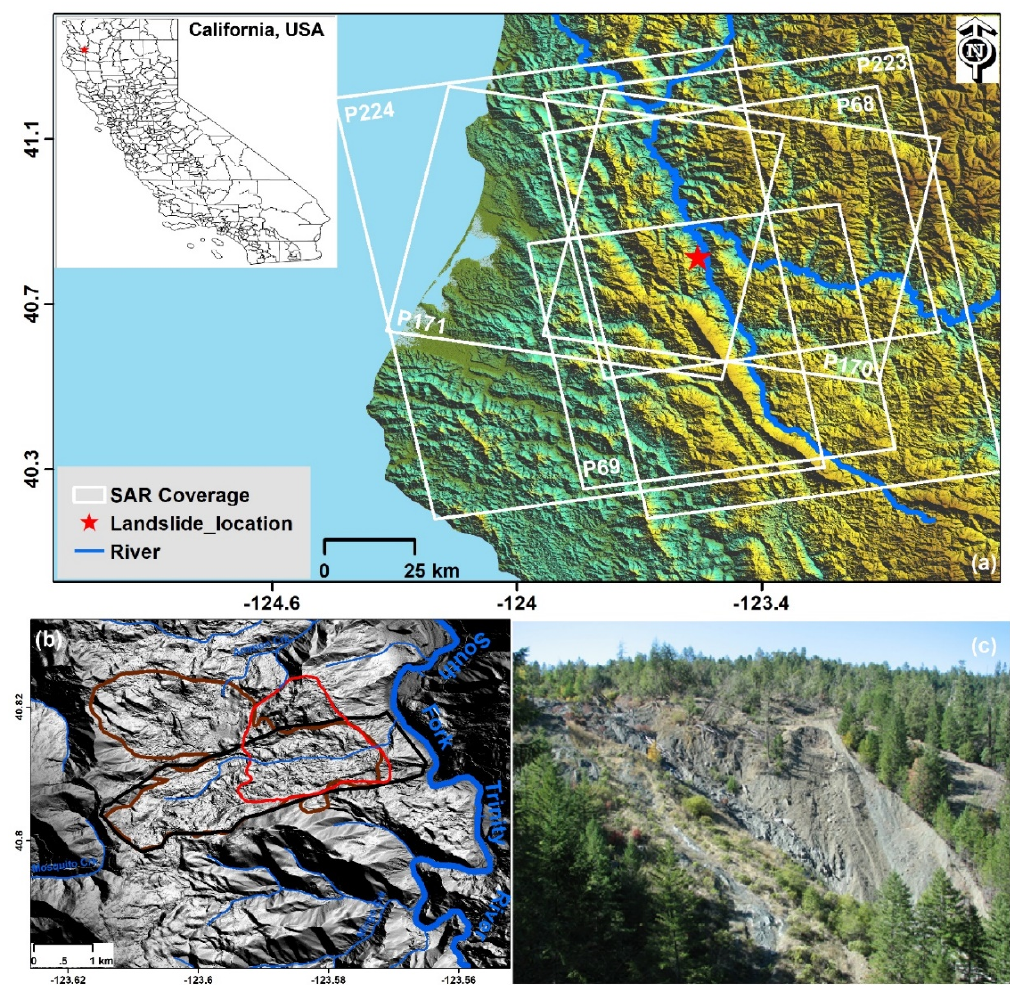
Figure 1. Study area and coverage of the SAR datasets. ( a ) Spatial coverage of ALOS PALSAR-1/2 satellite datasets (white boxes) superimposed on the shaded relief map. The red star represents the study area, while the blue lines represent the main rivers in the study area. The inset map presents the location of the study area in northern California, USA. ( b ) Enlarged shaded relief map of the Three Bears landslide generated by 1-m resolution LiDAR DEM. The blue lines show creeks and streams, and the thick blue line represents the South Fork Trinity River (SFTR). The brown polygon shows the dormant landslides identified by the United States Forest Service (USFS) while the polygon outlined in black indicates the boundary of the Cedar Grove Ranch Earthflow. The active landslide identified by Zhao et al. [10] is highlighted by a thick red polygon. ( c ) A field photo of the landscape around the Three Bears landslide (view northwest), provided by Juan de la Fuente.